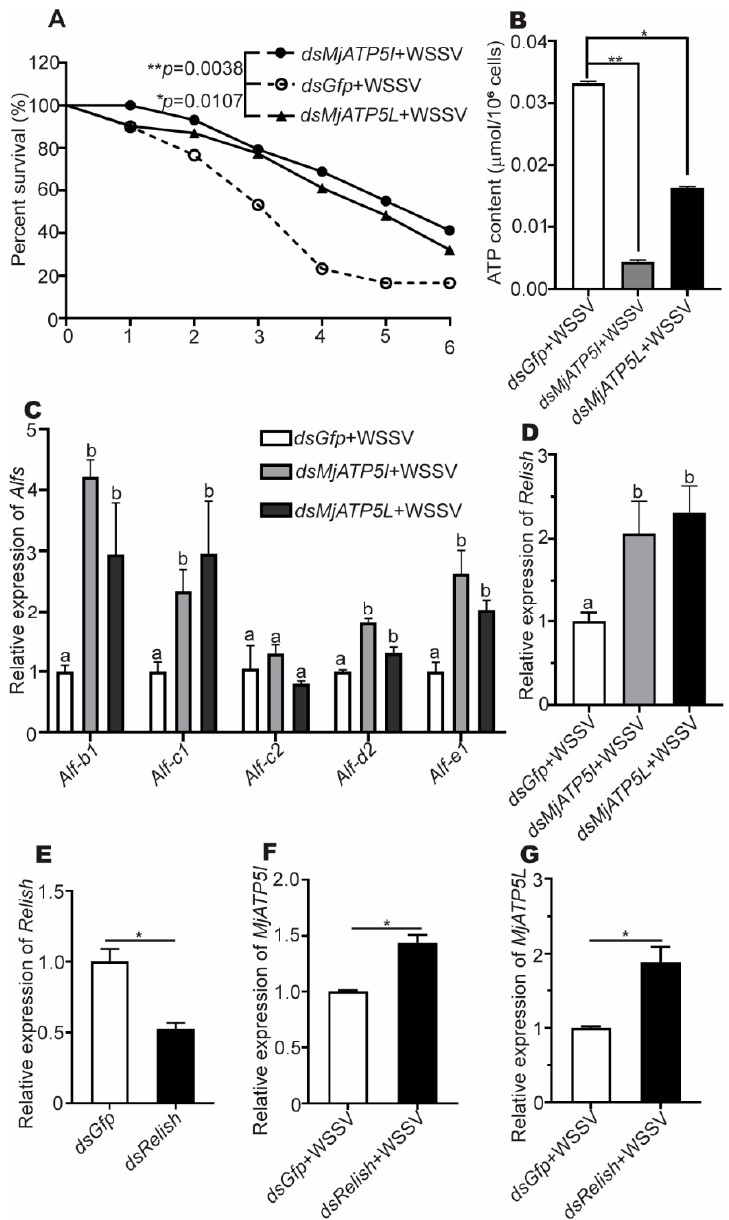
Figure 7. The survival rate, ATP content detection, and the genes relative expression after RNAi and WSSV challenge. ( A ) Survival rates of the dsMjATP5I -injected and dsMjATP5L -injected shrimp com- pared with the dsGfp -injected shrimp after WSSV infection. The survival rate was calculated to pre- sent the survival curves as Kaplan–Meier plots. Differences between the MjATP5I RNAi group or MjATP5L RNAi group and the Gfp RNAi group were analyzed using the Log-rank test in the GraphPad Prism 8.0 program. ( B ) The content of ATP in hemocytes after MjATP5I and MjATP5L RNAi with WSSV challenge. The dsGfp -injected shrimp were used as the control. The results are expressed as the mean ± SD and significant differences were analyzed between the dsMjATP5I- in- jected or dsMjATP5L -injected group and the dsGfp -injected group using Student’s t -test. *, p < 0.05, **, p < 0.01. ( C , D ) Expression of Alfs ( C ) and Relish ( D ) in hemocytes after MjATP5I and MjATP5L knockdown. The columns are expressed as the mean ± SD, and the differences were calculated by the ordinary one-way ANOVA with multiple comparisons. The identical letters indicate there are no significant differences between the two groups for the same gene ( p > 0.05), while different letters indicate significant differences between two groups of the same gene ( p < 0.05). The dsGfp -injected shrimp were used as the control. ( E ) Expression of Relish in shrimp hemocytes after dsRelish injection. ( F , G ) The relative expression of MjATP5I ( F ) and MjATP5L ( G ) in hemocytes after Relish knockdown